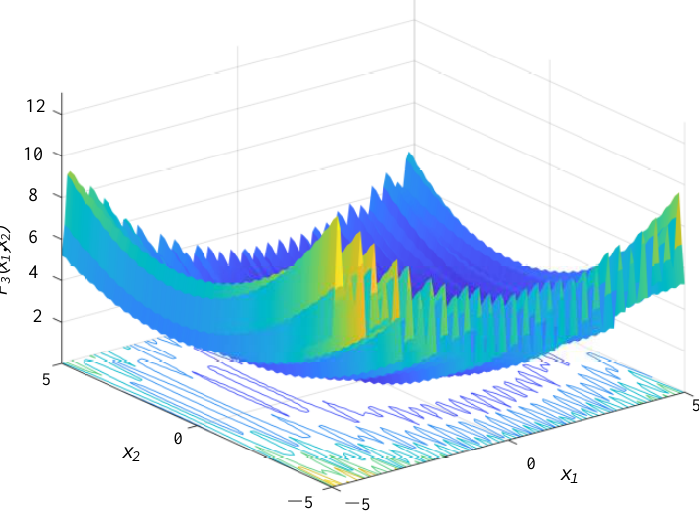
Figure 9. Testing function F 3 ( x ).